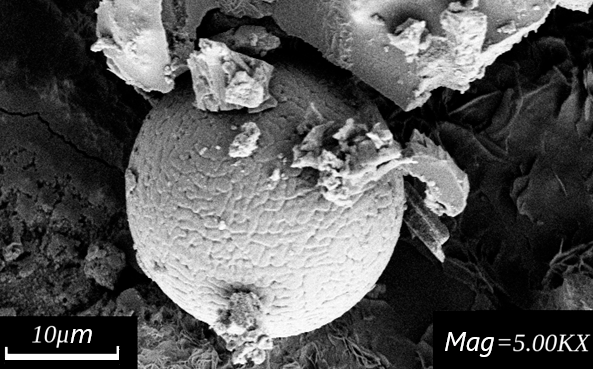
Figure 7. Electronic microphotograph of the weld between steel St3 and steel U7 (surface after 60 days of exposure). “Wasp’s nest” structure is calcium carbonate spherulite and angular plate structure is FeO(OH).